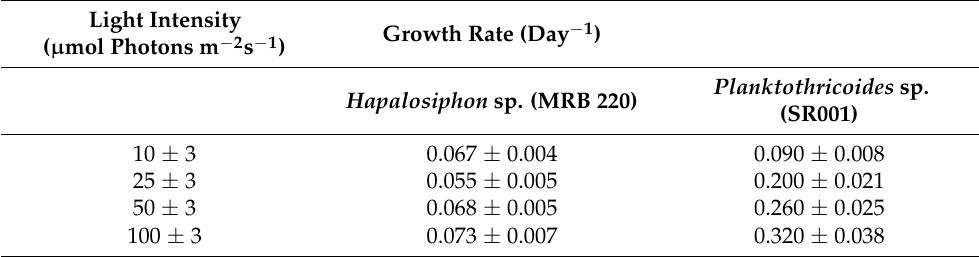
Table 1. Growth rates under different light intensity